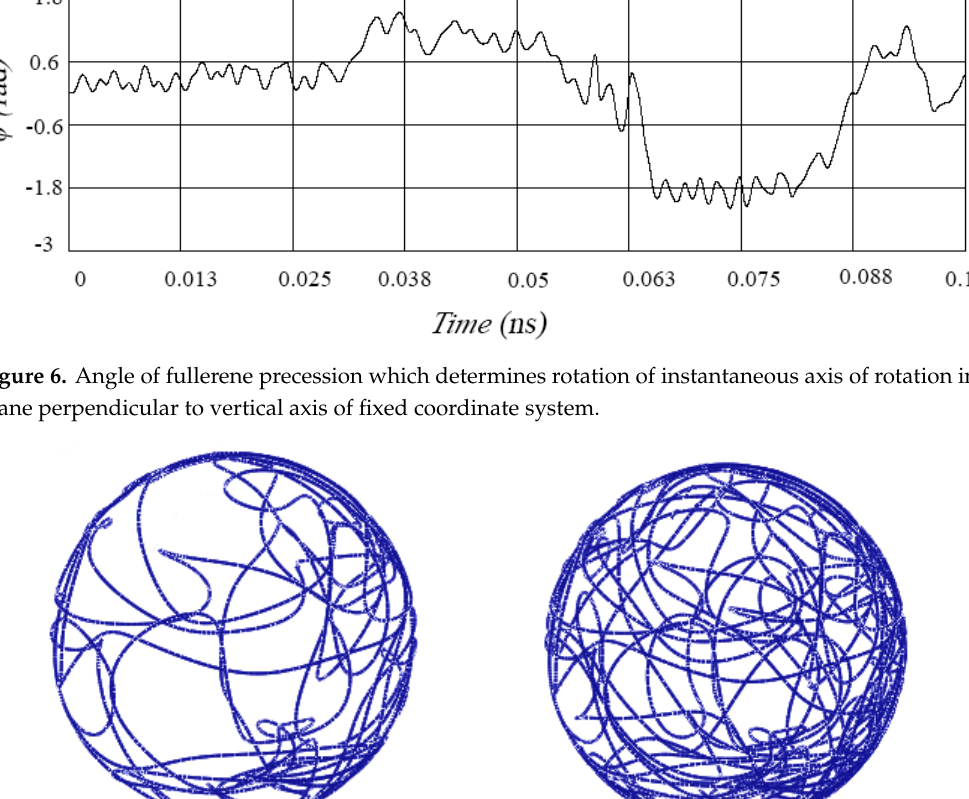
Figure 7. Trajectory of carbon atom on visualizing sphere t = 0.28 ns (left) and t = 2.625 ns (right).